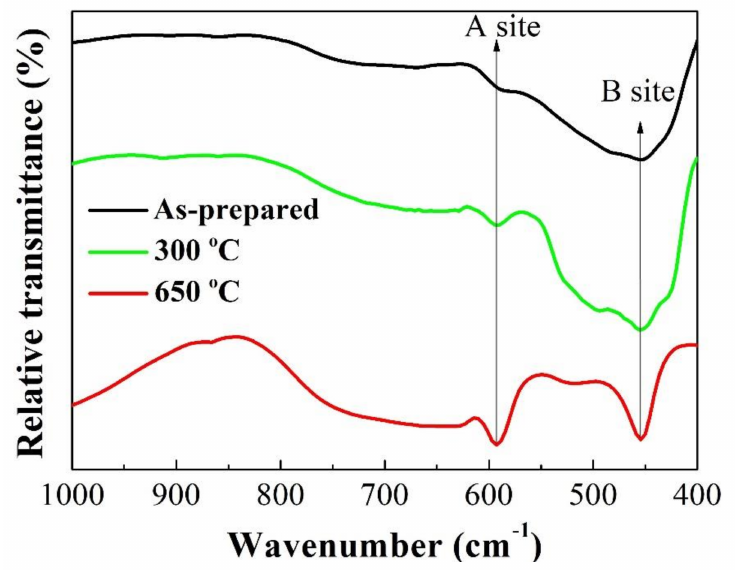
Figure 3. FT–IR spectra of as-prepared and calcined